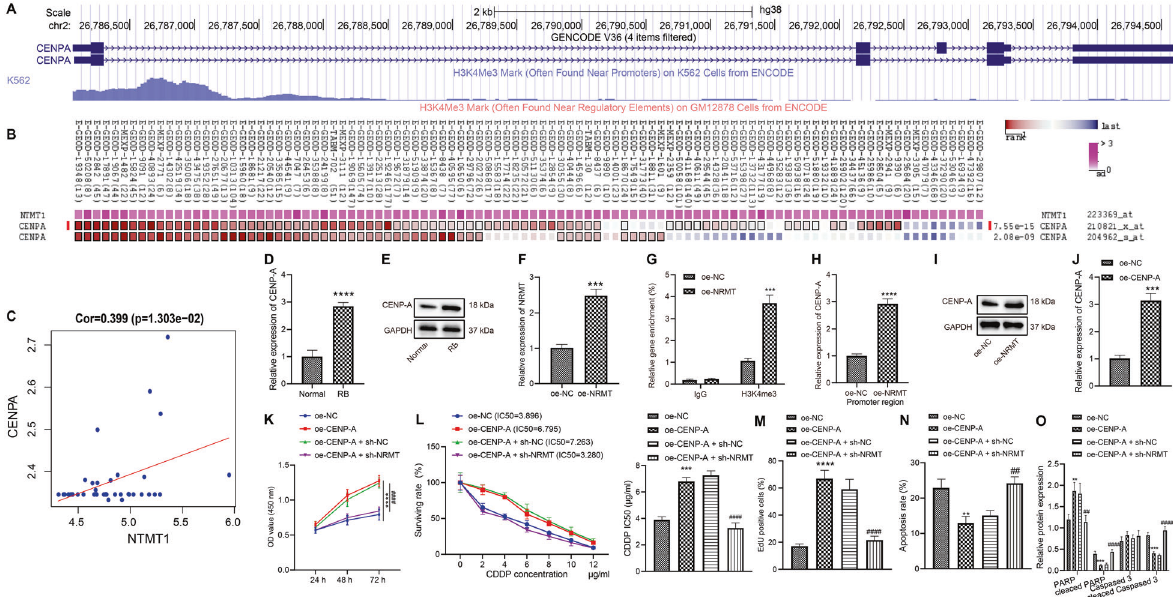
Fig. 2 NRMT inhibits chemosensitivity of WERI-RB-1/CDDP cells by promoting CENPA expression. A The methylation modi fi cation sites of CENPA obtained by UCSC analysis. B Co-expression between NRMT and CENPA identi fi ed by MEM analysis. C The positive correlation between CENPA and NTMT identi fi ed by analysis of microarray dataset GSE28133. D The differential expression of CENPA in retinoblastoma determined by RT-qPCR. E The differential expression of CENPA in retinoblastoma determined by western blot analysis (* p < 0.05 vs. normal tissues). F The overexpression ef fi ciency of NRMT determined by RT-qPCR. G H3K4me3 enrichment determined by ChIP assay. H The expression of CENPA measured by RT-qPCR. I The expression of CENPA measured by western blot analysis. J Overexpression ef fi ciency of CENPA determined by RT- qPCR (* p < 0.05 vs. cells transfected with oe-NC). K Cell viability assessed by CCK8 assay. L IC 50 value determined by CCK8 assay. M Cell proliferation assessed by EdU assay. N Cell apoptosis assessed by fl ow cytometry. O Expression of PARP, Cleaved PARP, caspase 3, and Cleaved caspase 3 in cells after transfection determined by western blot analysis. * p < 0.05 vs. cells transfected with oe-NC, # p < 0.05 vs. cells transfected with oe-CENPA + sh-NC. */# p < 0.05; **/## p < 0.01; ***/### p < 0.001; ****/#### p < 0.0001. The experiment was independently repeated three